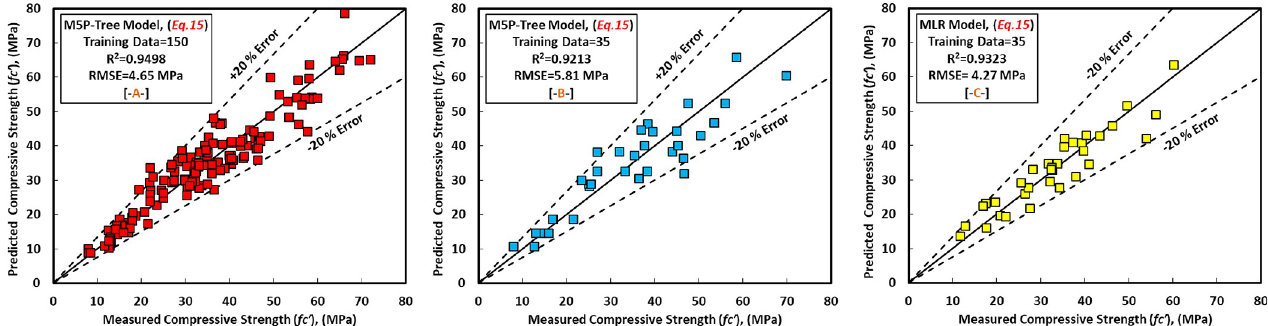
Fig 20. Comparison between measured and predicted compressive strength of GGBS/FA-GPC mixture using M5P model, (a) training data, (b) testing data, (c) validating data.